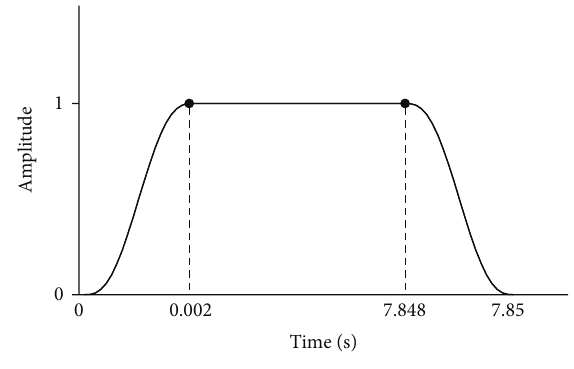
Figure 4: Smooth step amplitude